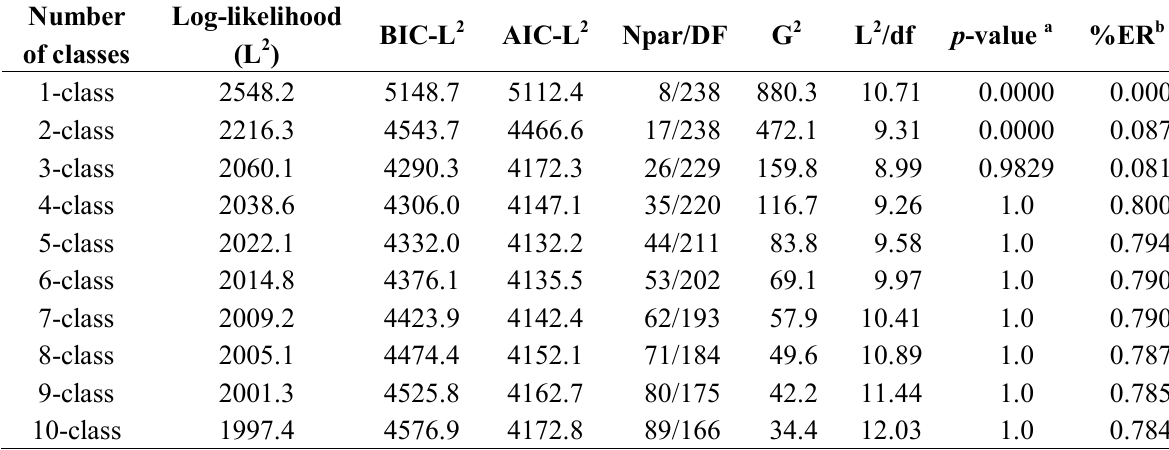
Table 1. Fit statistics from the latent class